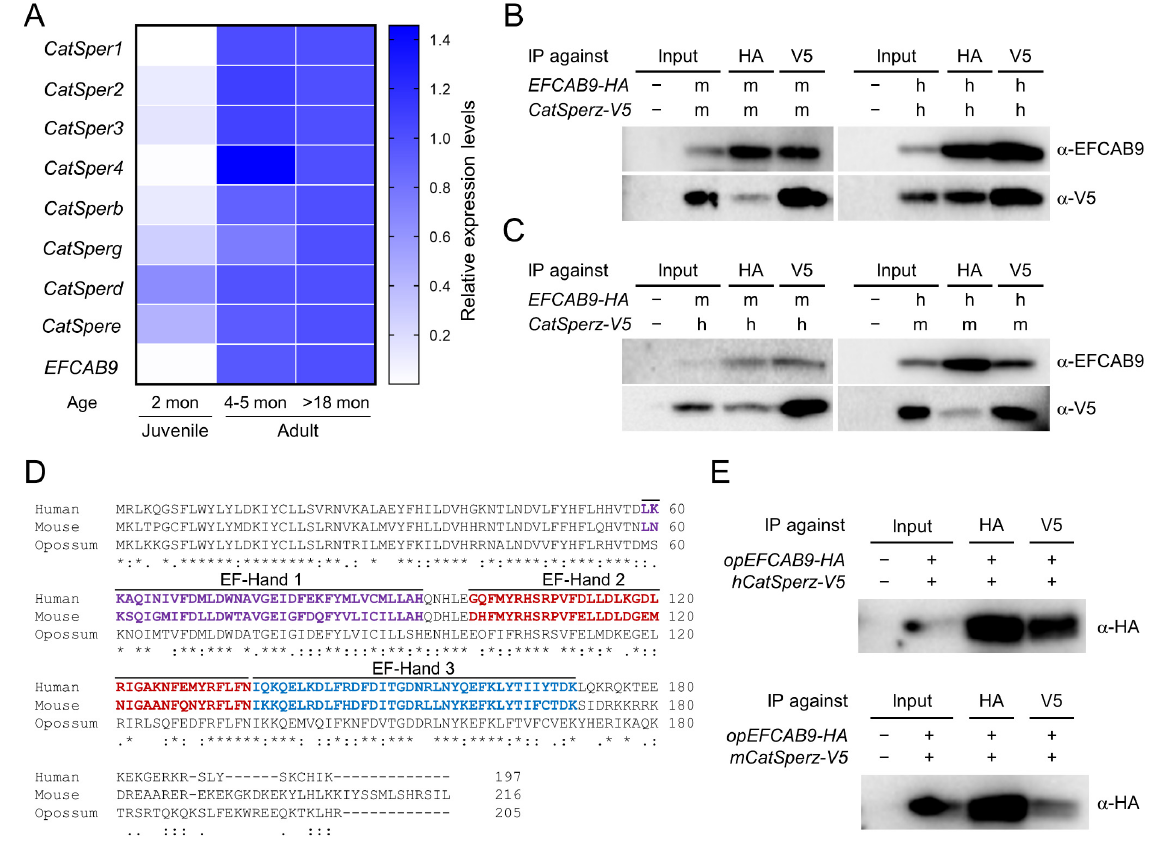
Figure 5. Gray short-tailed opossum shares molecular characteristics of CatSper subunits conserved among eutherians. ( A ) mRNA expression pattern of CatSper subunits in developing testes of the gray short-tailed opossum. Relative expression levels of CatSper subunits are represented in a heatmap from the qRT-PCR analysis. CatSper expression in the testis is higher in adults (4–5 months and over 18 months; n = 3 each) compared to juvenile males (2 months old; n = 2). Expression levels in over 18-month-old males were set to 1-fold. ( B , C ) Conserved interaction of eutherian EFCAB9 and CatSper ζ . EFCAB9 and CatSper ζ from the same ( B ) or different ( C ) species were transiently expressed in 293T cells and co-immunoprecipitated. m, mouse; h, human. ( D ) Amino acid sequence alignment of human, mouse, and opossum EFCAB9. Marked are the annotated three EF-Hands in human and mouse EFCAB9. ( E ) Opossum EFCAB9 can form a complex with CatSper ζ orthologs from other eutherian mammals. Transiently expressed opossum EFCAB9 and human (top) or mouse (bottom) CatSper ζ in heterologous system are co-immunoprecipitated. See also Figure S4.